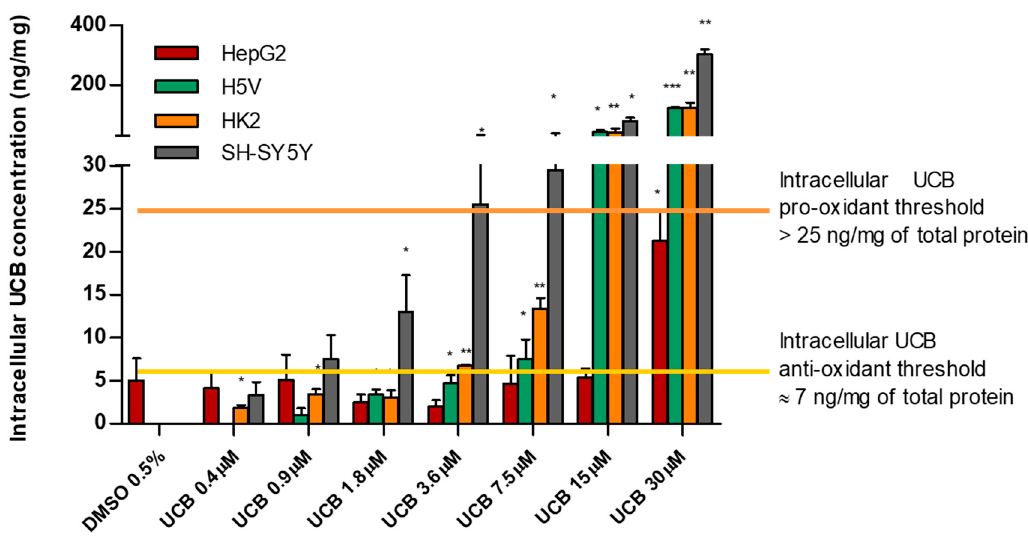
Figure 6. Intracellular UCB prooxidant and antioxidant thresholds. The cell lines were exposed for 24 h to the increasing UCB concentration (from 0.4 to 30 µ M in the presence of 30 µ M BSA) or 0.5% DMSO. Data are expressed as mean ± SD of three independent experiments, UCB concentrations were recalculated per mg of protein. p -values represent comparison with control cells. * p < 0.05, ** p < 0.01, *** p < 0.001.